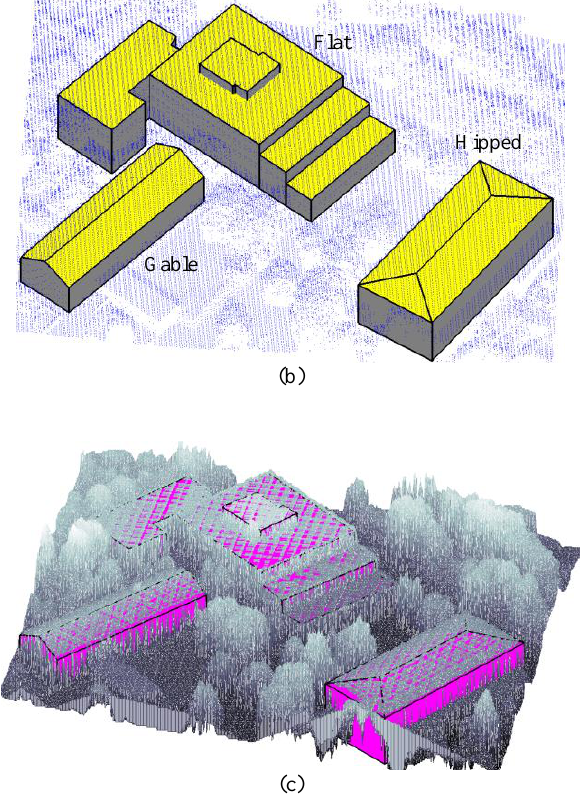
Figure 8. a) Aerial image, b) building models on DSM, c)